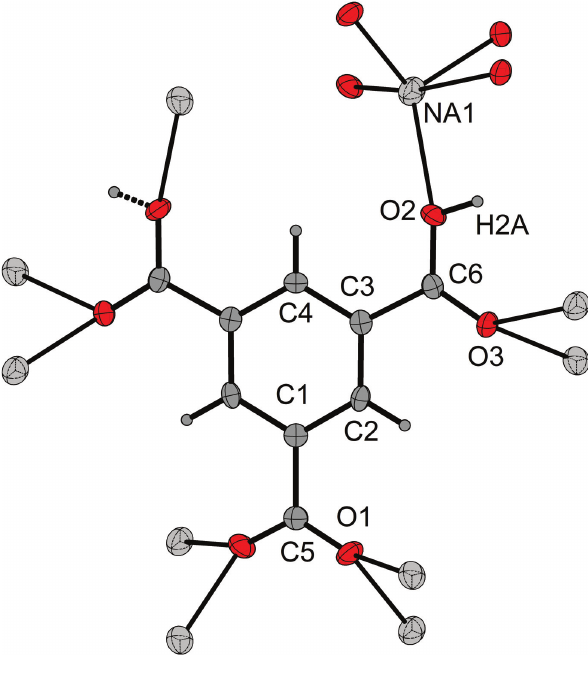
Table 1: Data collection and handling.